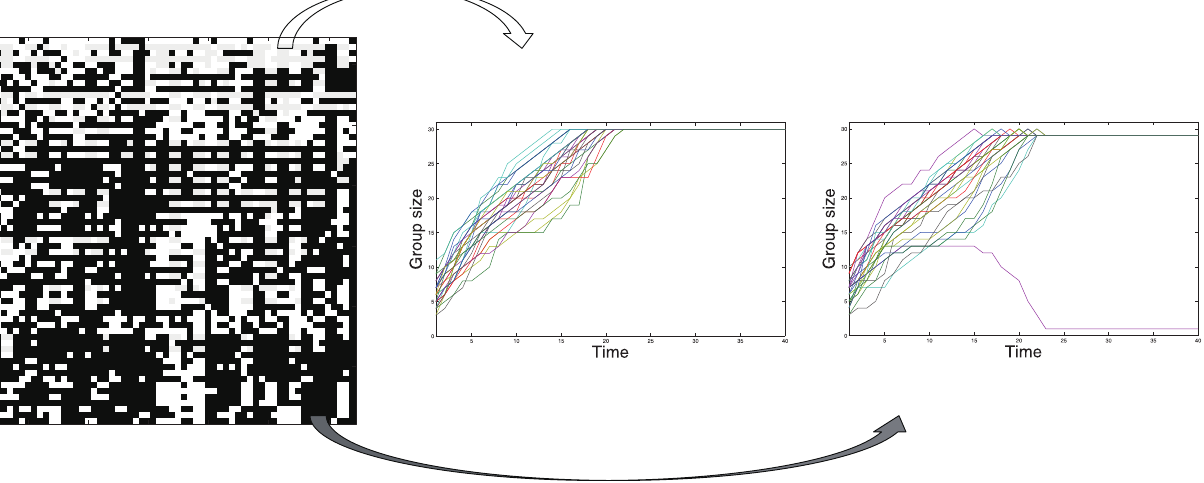
Figure 4. A subset of the initial configuration spaces (left) and two examples of the group formation. The results from 64 2 different initial configurations are visualized in the checker board. The white cell represents an initial configuration that leads to one entire group, while the black represents one that ends up forming ostracism. The ratio of liking among people at t =0 is 1/3 and the parameter a =1 is used.